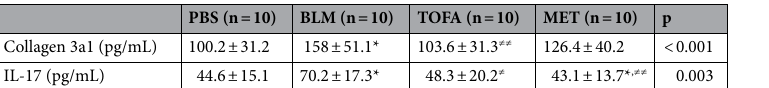
Table 3. The levels of collagen 3a1 and IL-17 in skin tissue of study groups. BLM bleomycin, MET metformin, PBS phosphate-buffered saline, TOFA tofacitinib . Data were expressed as mean ± standard deviation. When compared with the PBS group: *p < 0.01. When compared with the BLM group: ≠ p < 0.05, ≠≠ p <